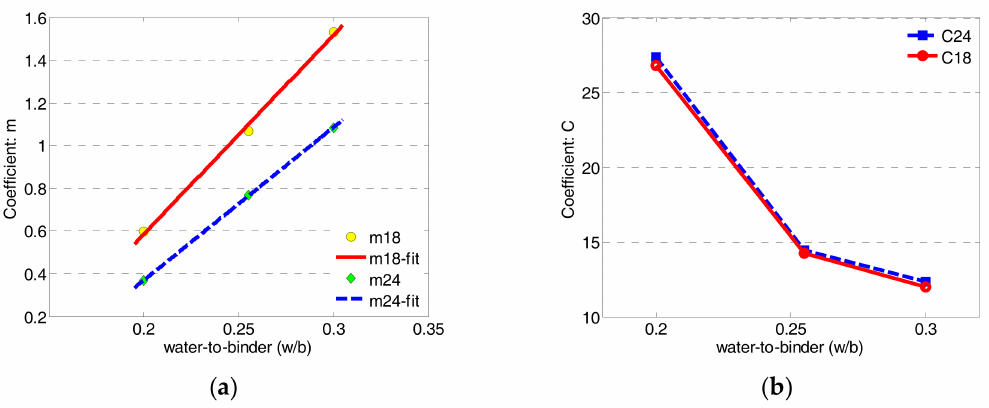
Figure 10. Comparison of regression coefficients versus w / b at dual frequency: ( a ) regression coefficient m ; ( b ) regression coefficient C .